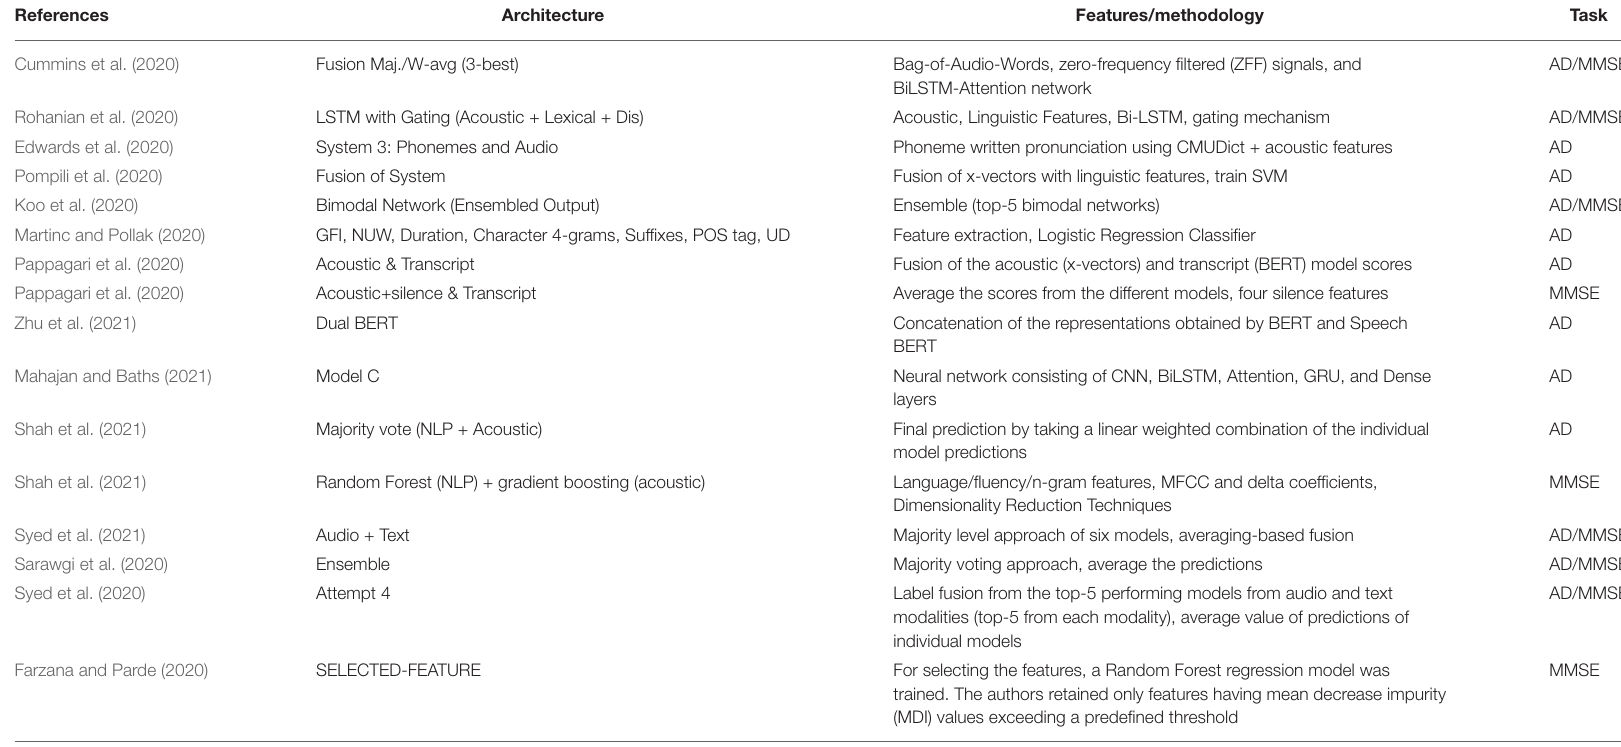
TABLE 1 | Overview of the multimodal state-of-the-art approaches, which are later compared with our